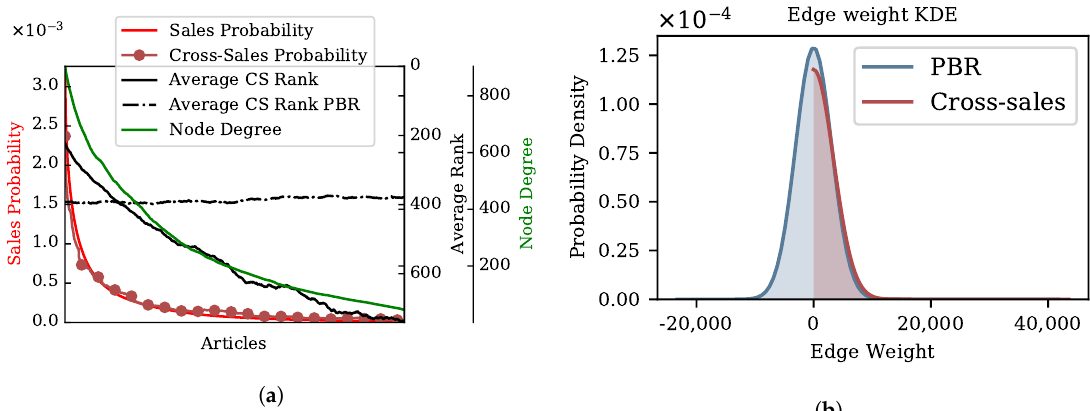
Figure 2. Popularity bias and re-ranking. ( a ) Depiction of overall sales probability and cross-sales (CS) probability ( y 1-axis) and the node degree (number of neighbors) ( y 3-axis) for all products. The average cross-sales rank ( y 2-axis) is shown for initial cross-sales statistics (solid black line) and the probability based re-ranking (PBR) approach (black dotted line). Note that the average rank is proportional to the popularity of the respective product in the initial cross-sales statistics, but this relation disappears in the PBR approach. ( b ) The probability density of edge weights (kernel density estimation (KDE)) shows the distribution of edge weights in the initial cross-sales based graph, as well as in the PBR based